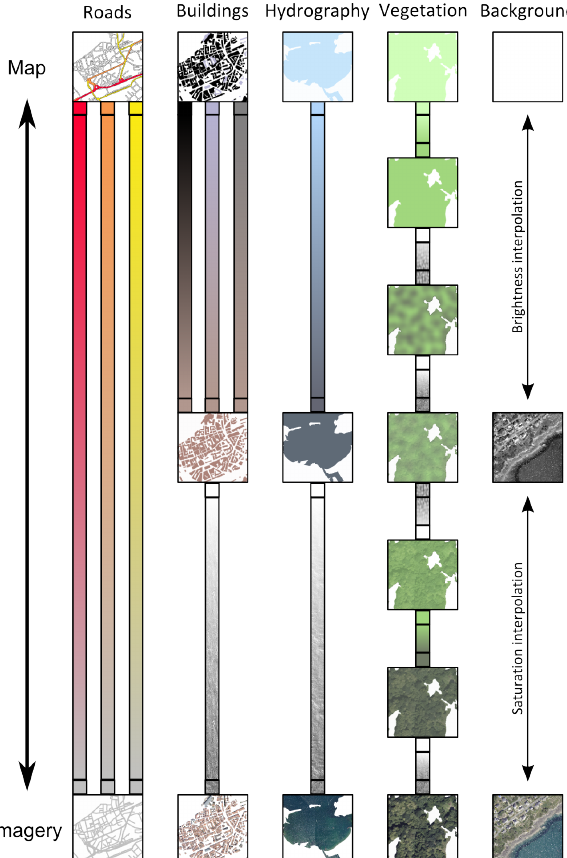
Figure 15: Symbolization interpolation components and pivot symbolizations used to create our style